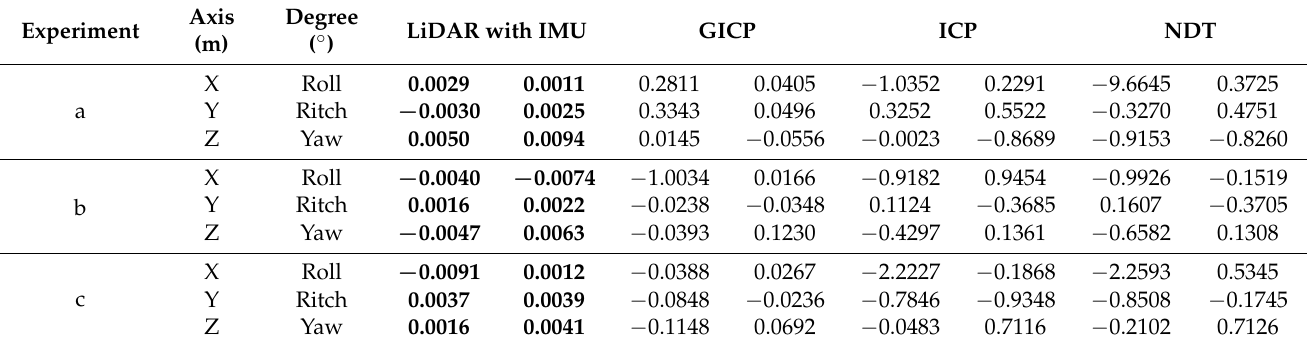
Table 1. Absolute position and pose changes of different point cloud registration